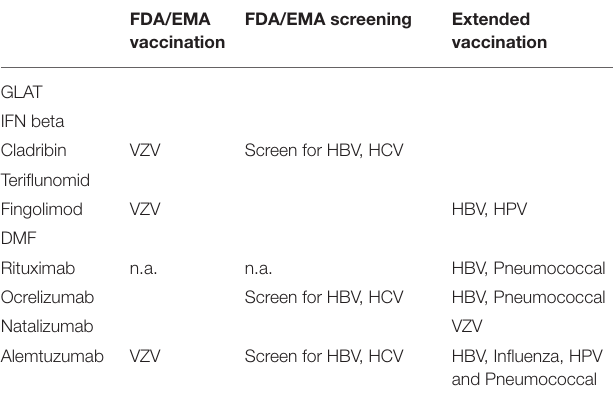
TABLE 2 | Recommended vaccination in MS patients in dependency of